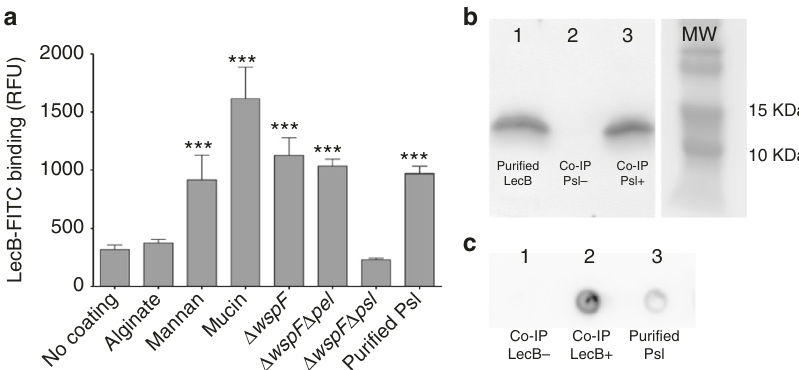
Fig. 1 LecB binds to the exopolysaccharide Psl. a FLLA assay shows that LecB is able to bind to fucose/mannose-containing polysaccharides immobilized on the wells of microtiter plates. FITC-conjugated LecB does not bind to uncoated or glucose-rich polysaccharide alginate, and Pel-rich materials ( Δ wspF Δ psl ). However, it binds to mannan, fucose-rich proteins (mucin), Psl-rich materials ( Δ wspF and Δ wspF Δ pel ), and to puri fi ed Psl. *** p < 0.0001, t -test, n > 3. b LecB western blot showing coimmunopreciptation of LecB and Psl. Lane 1 was loaded with puri fi ed LecB. PtnG Dynabeads coated with anti-Psl antibodies were incubated with LecB (lane 2) or puri fi ed Psl and LecB (lane 3). Eluted material was immunoblotted using anti-LecB antibodies. c Psl blot showing coimmunopreciptation of LecB and Psl. Protein G Dynabeads coated with anti-LecB antibodies were incubated with puri fi ed LecB (lane 1) or with LecB and Psl (lane 2). After wash steps, eluted material was immunoblotted using anti-Psl antibodies. Lane 3 was loaded with puri fi ed